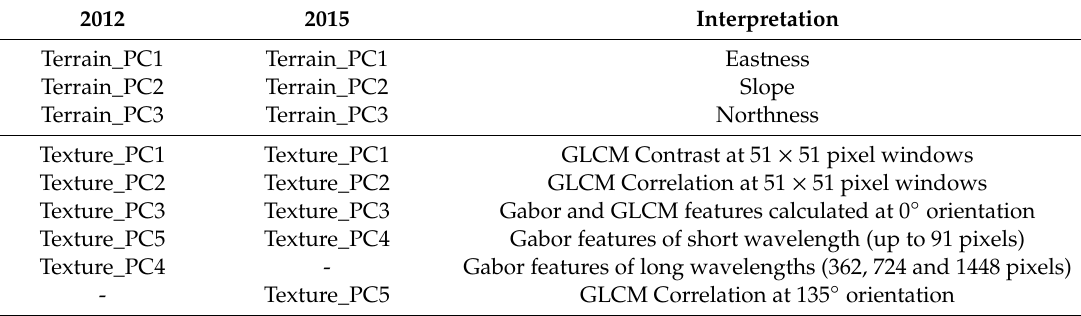
Table 6. Interpretation of the coe ffi cients of the main Terrain and Texture PCs (see Supplementary Materials Tables S1–S3 for full